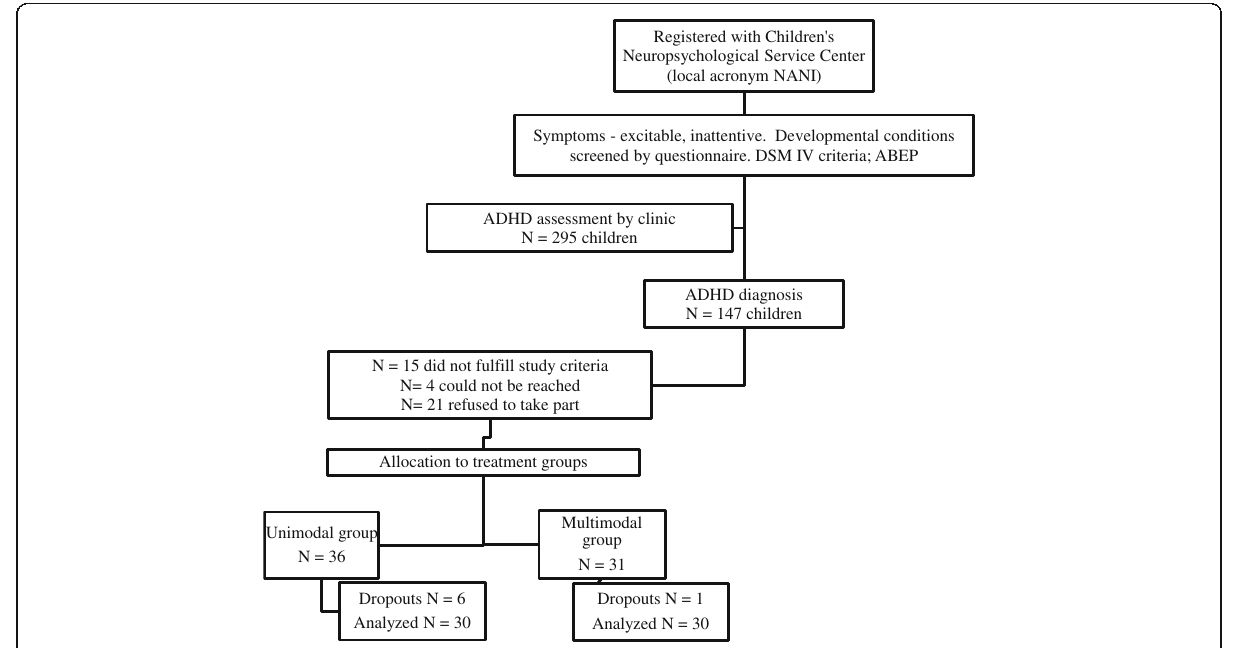
Fig. 1 Flowchart. Note: 41 children were directed to other intervention studies (other types) at the center during this